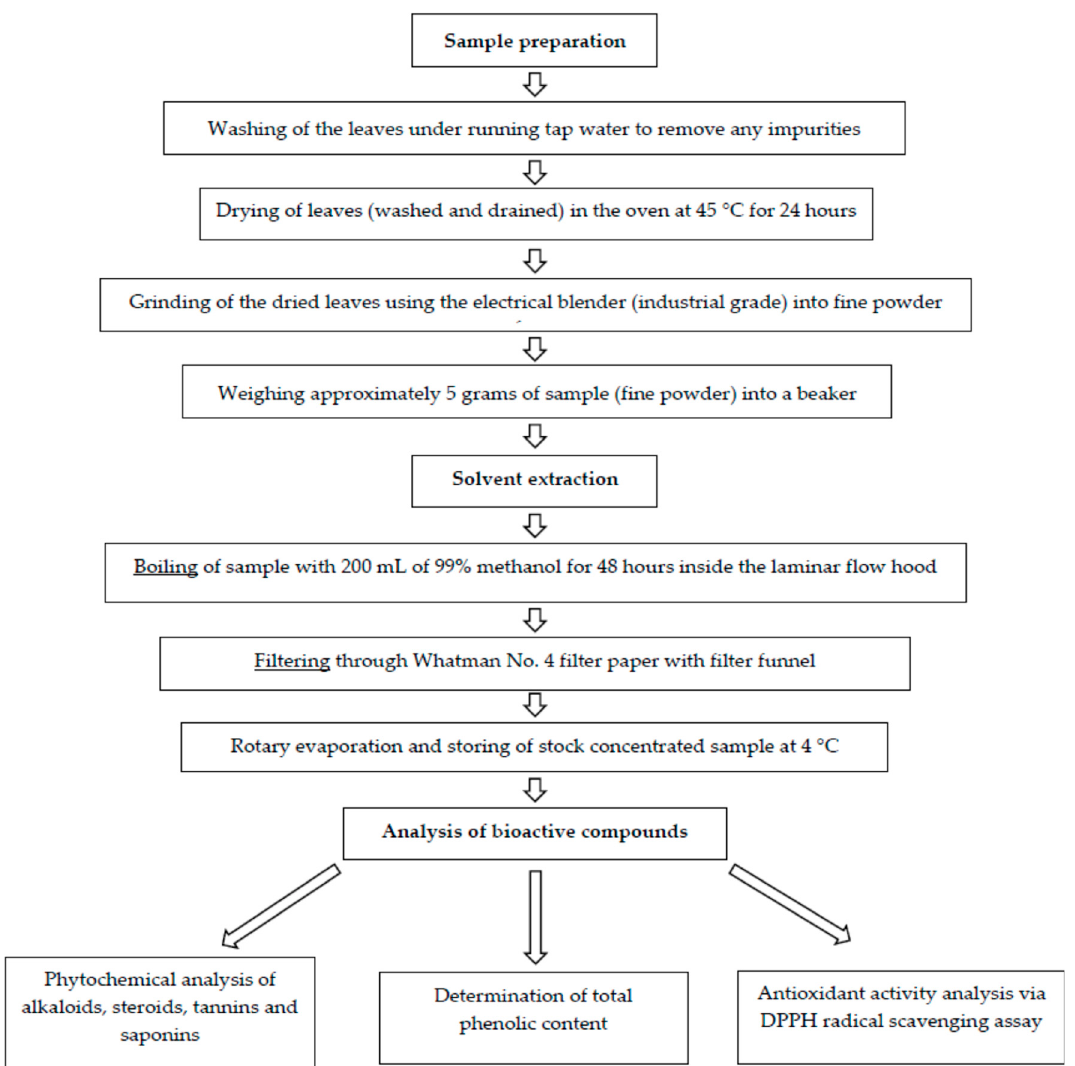
Figure 1. Experimental outline of Cissus hastata leaf crude extract preparation toward analysis of the bioactive compounds.